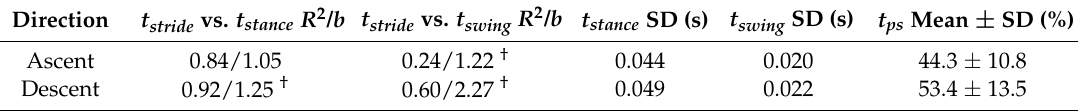
Table 1. Gait cycle timing variables for running while ascending and descending stairs.